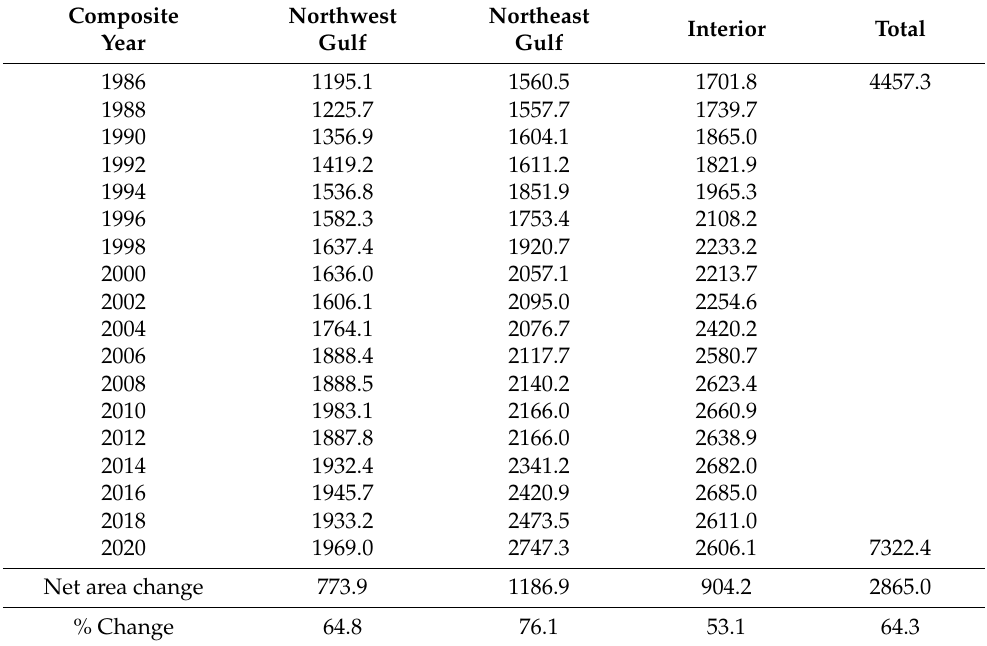
Table A2. Supraglacial debris area by biannual composite and aggregated climate divisions. Areas are km 2